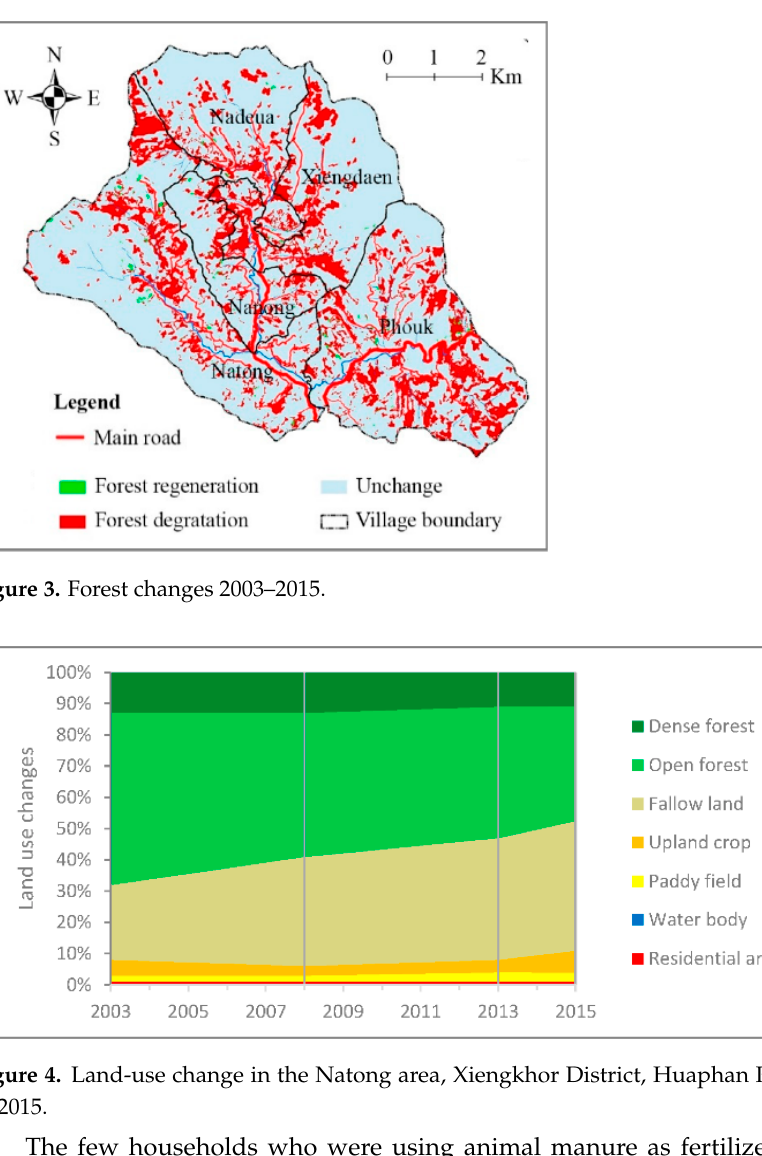
Figure 3. Forest changes 2003–2015.